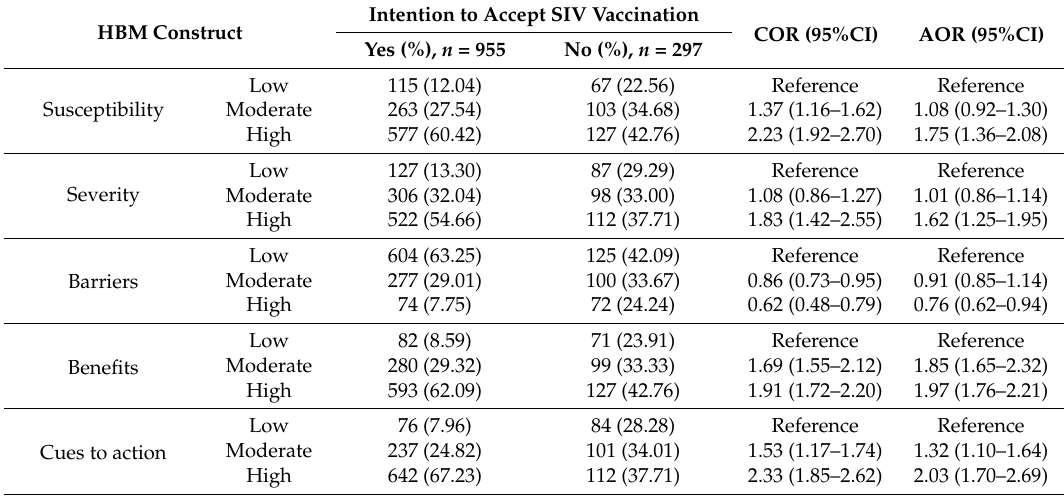
Table 3. Bivariate and multivariable analysis indicating associations between HBM constructs and the acceptance of SIV vaccination among pregnant women, in Zhejiang province,